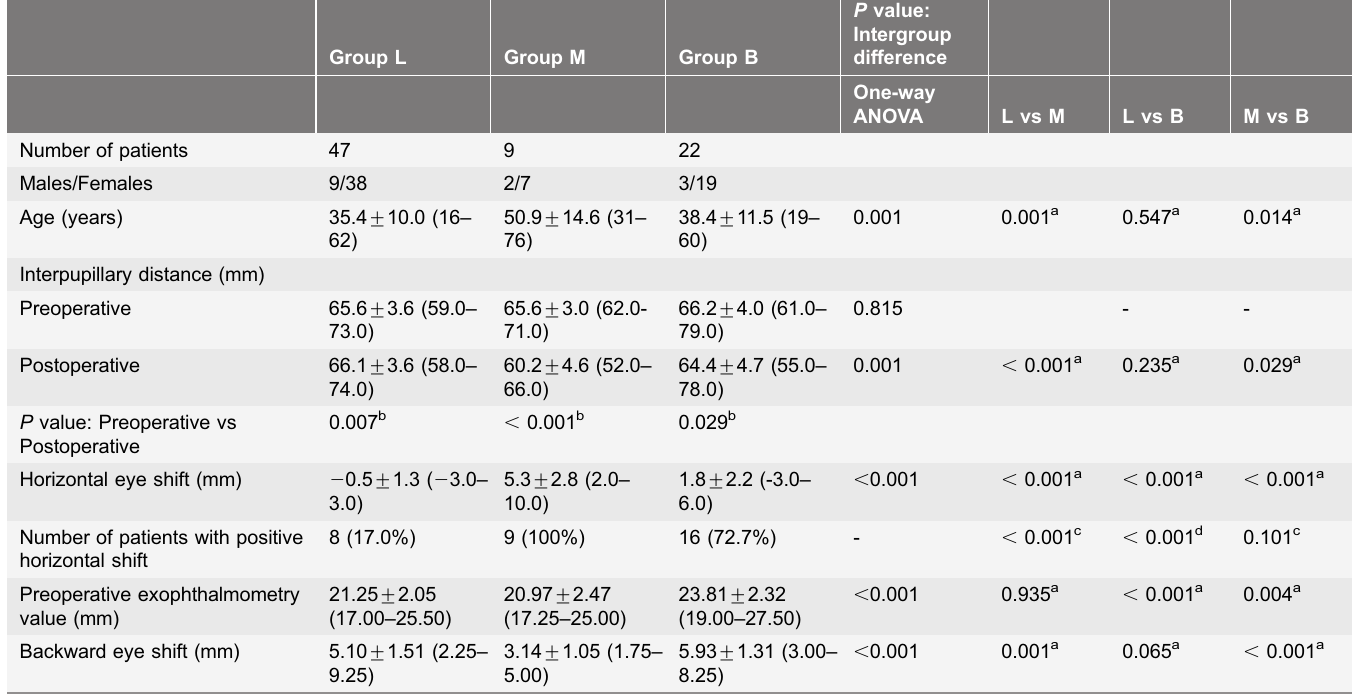
Table 2 . Summary of patient data and measurement results in each group, and statistical comparisons between pre- and postoperative values between the groups.